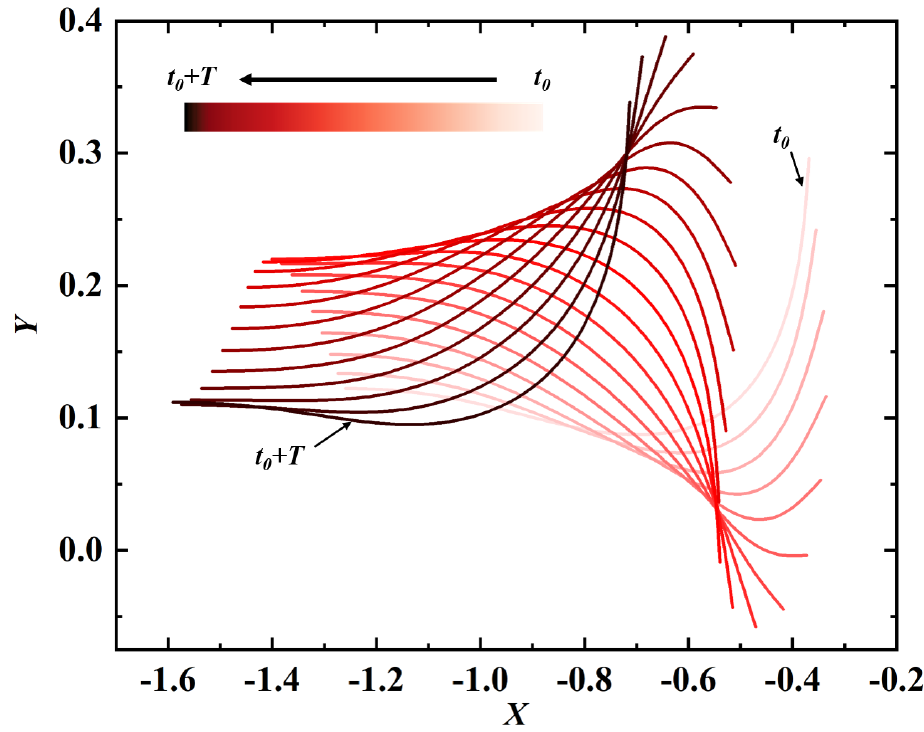
Figure 6. Shapes of the propulsor at different time instants within one period. The change of color from light to dark in the shapes signifies the increase of time. t 0 and T are the initial time instant and the dimensionless